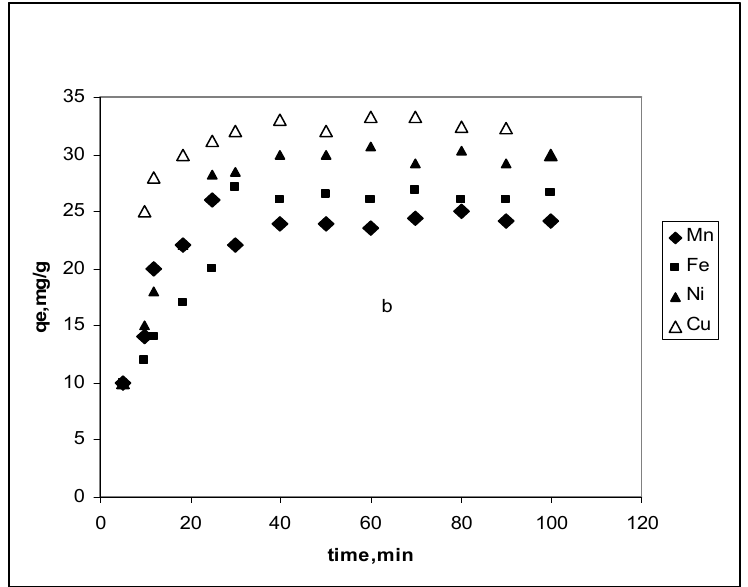
Figure 2. CBC contact time effect on Mn 2+ , Fe 2+ , Ni 2+ and Cu 2+ removal. Conditions: C 20 mg·L –1 ; CBC dose, 0.02 g; pH 5.1 and temperature, 298